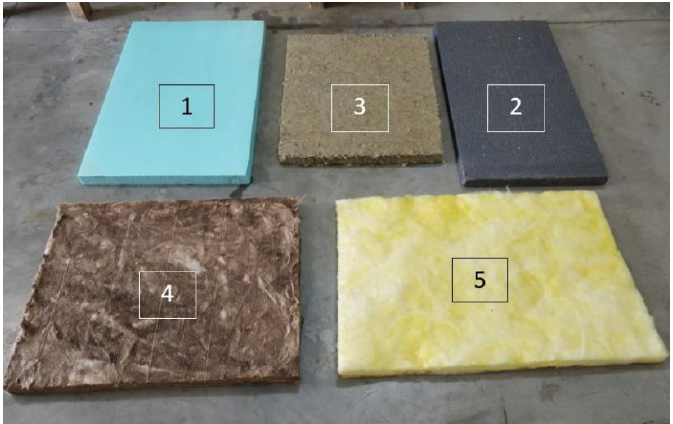
Figure 1. The five insulation materials used—described in Table 1. Table 1. Sample code correspondence to the insulating materials.